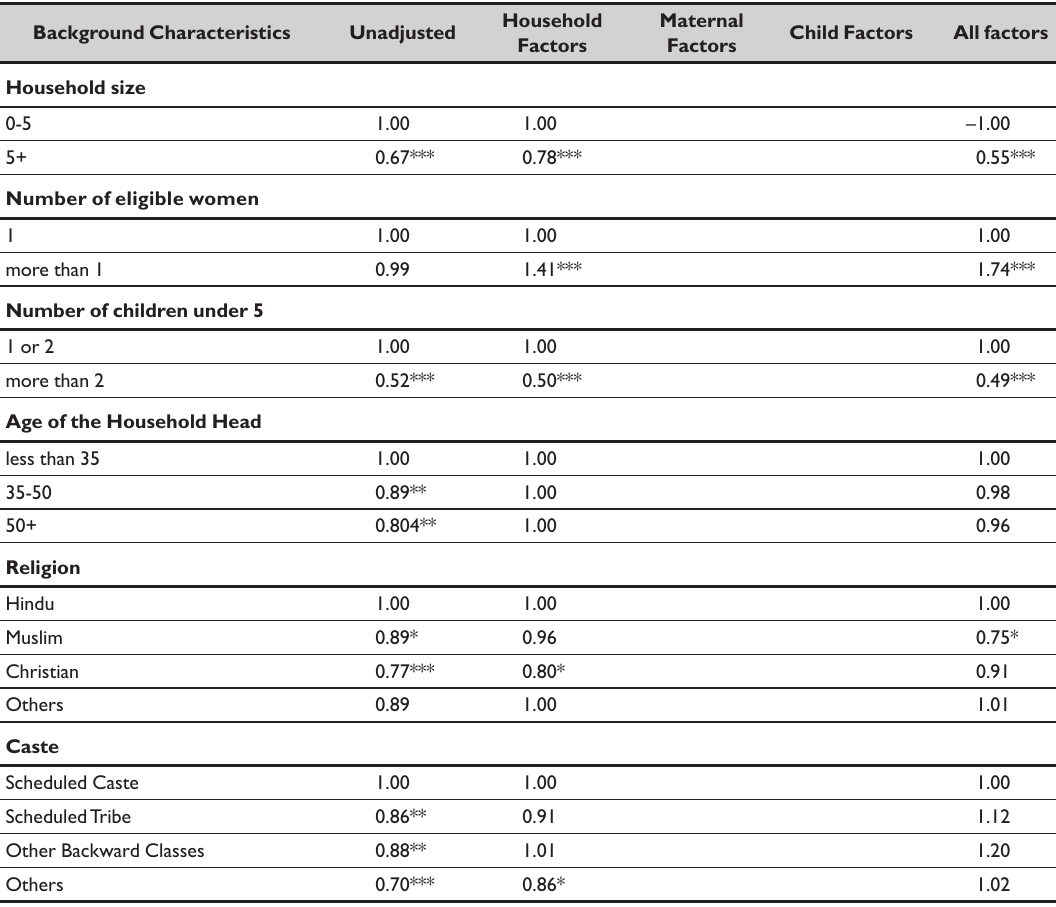
Table 2. Cox proportional hazard model showing the odds of infant death in male headed households, NFHS-3 (2005-06), India Background Characteristics Unadjusted